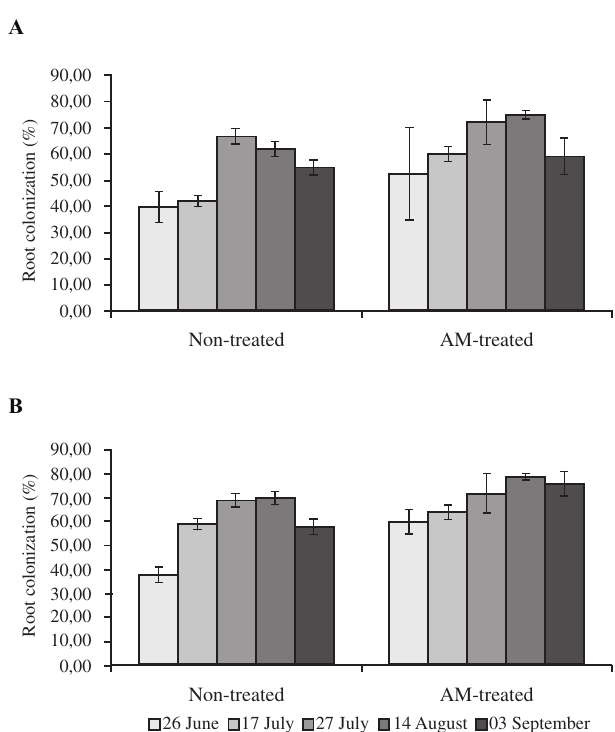
Figure 3. Colonization of pepper roots by AM fungi as affected by sampling times and pepper variants. A: Capsicum annuum L. var. longum cv. Kalocsai, B: Capsicum annuum L. var. longum cv.